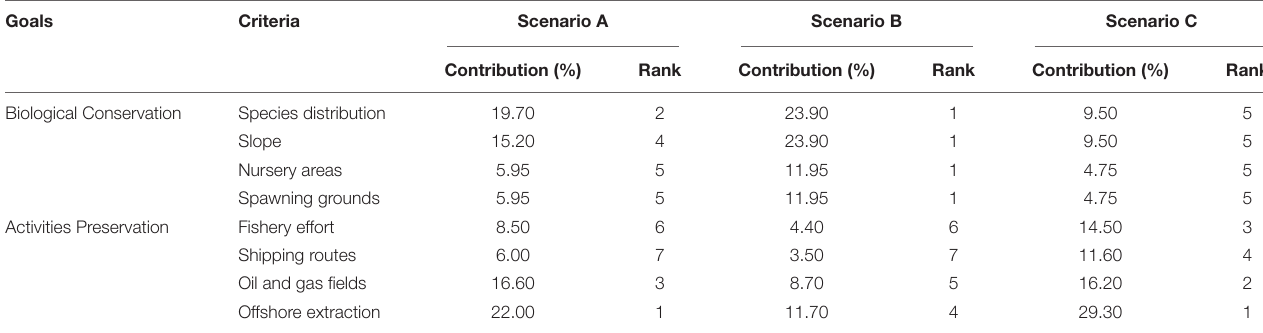
TABLE 2 | Contributions and ranks of criteria to the final results in the different scenarios.